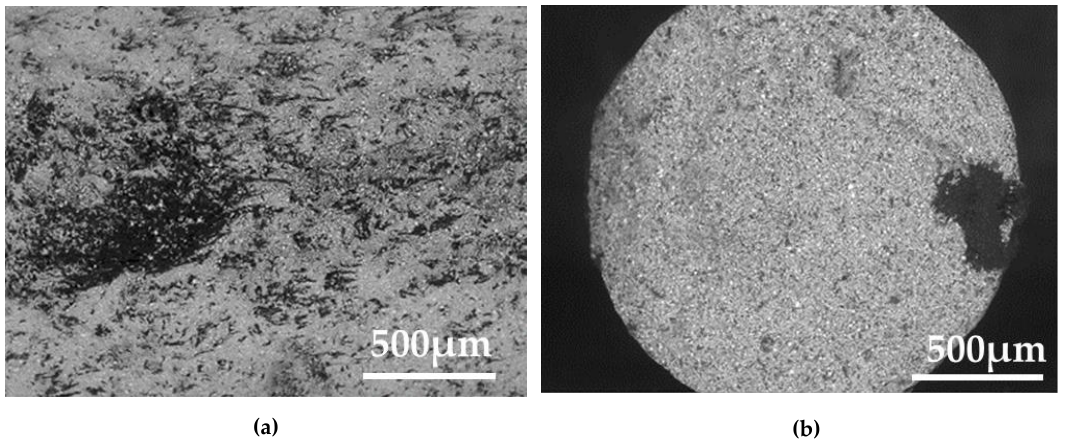
Figure 11. SEM micrographs of fracture surfaces of ( a ) a feedstock and ( b ) a filament.